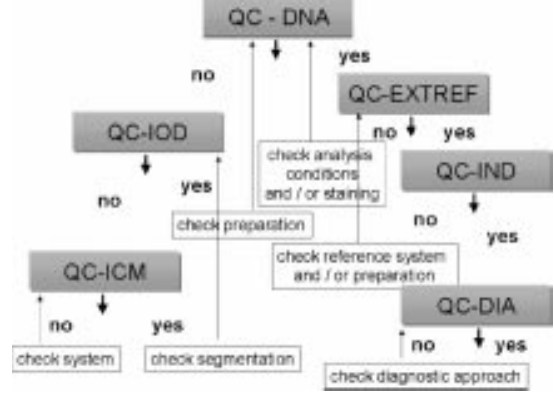
Fig. 4. Framework of quality control tests.